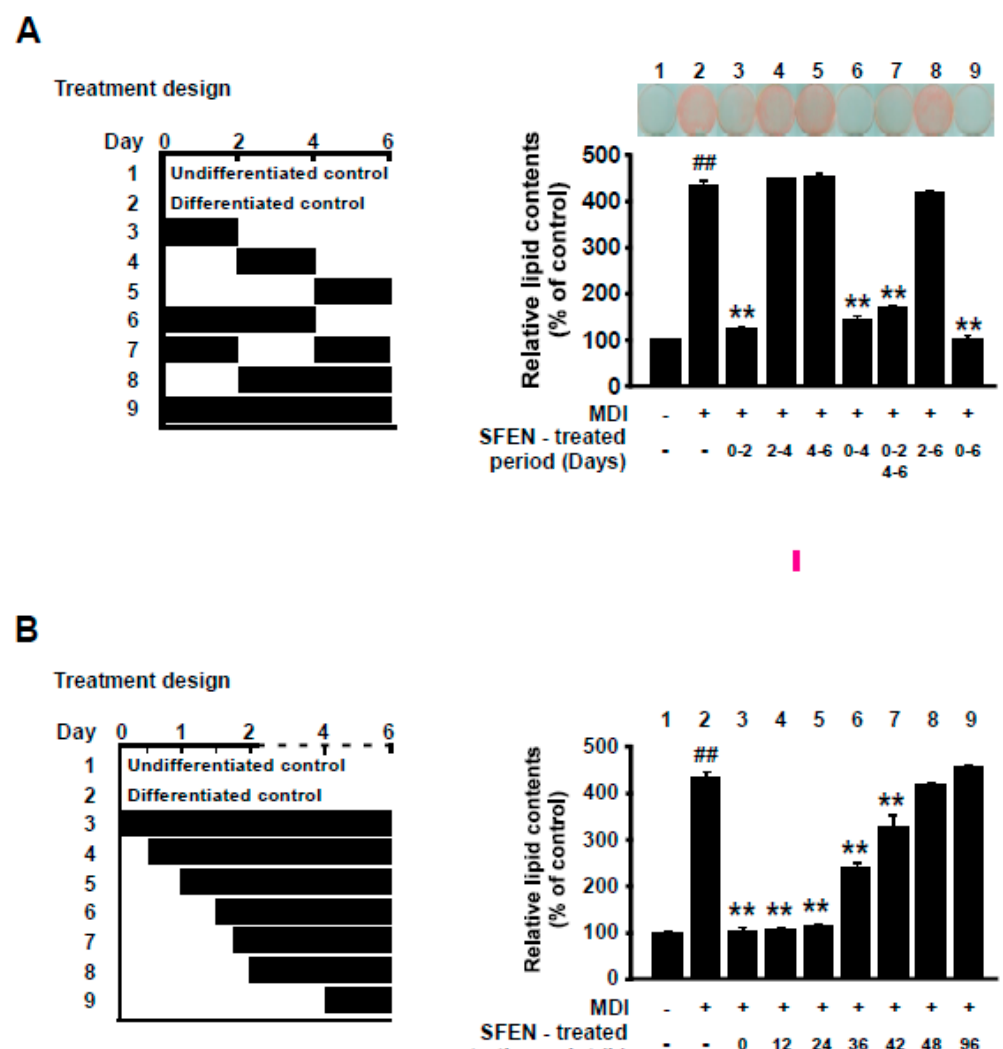
Figure 3. Effect of sulforaphene (SFEN) on differentiation medium-induced adipogenesis during the latter half of the early stage (24–48 h) of adipogenesis in 3T3-L1 pre-adipocytes. ( A , left) The experimental design indicating the time points of each SFEN treatment after addition of mouse adipocyte differentiation medium (MDM). ( A , right) Image of cells stained with Oil Red O, and intracellular lipid accumulation when cells were exposed to SFEN at different time points. ( B , left) The experimental design indicating the time points of each SFEN treatment. ( B , right) Results of quantitative analysis of Oil Red O-stained 3T3-L1 pre-adipocytes. We tested the effects of SFEN with Oil Red O staining after inducing differentiation for six days by replacing each medium and treating SFEN at the indicated time duration in “treatment design”. Data were obtained from three independent experiments and are expressed as the means ± standard deviation ( n = 3). ##, significant di ff erence ( p < 0.01) between the control and the MDM control. **, significant di ff erence ( p < 0.01) between a treatment and the MDM